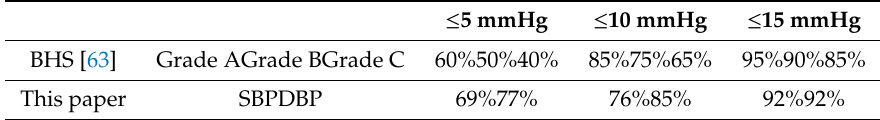
Table 14. Comparison of this paper results with the British Hypertension Society (BHS)